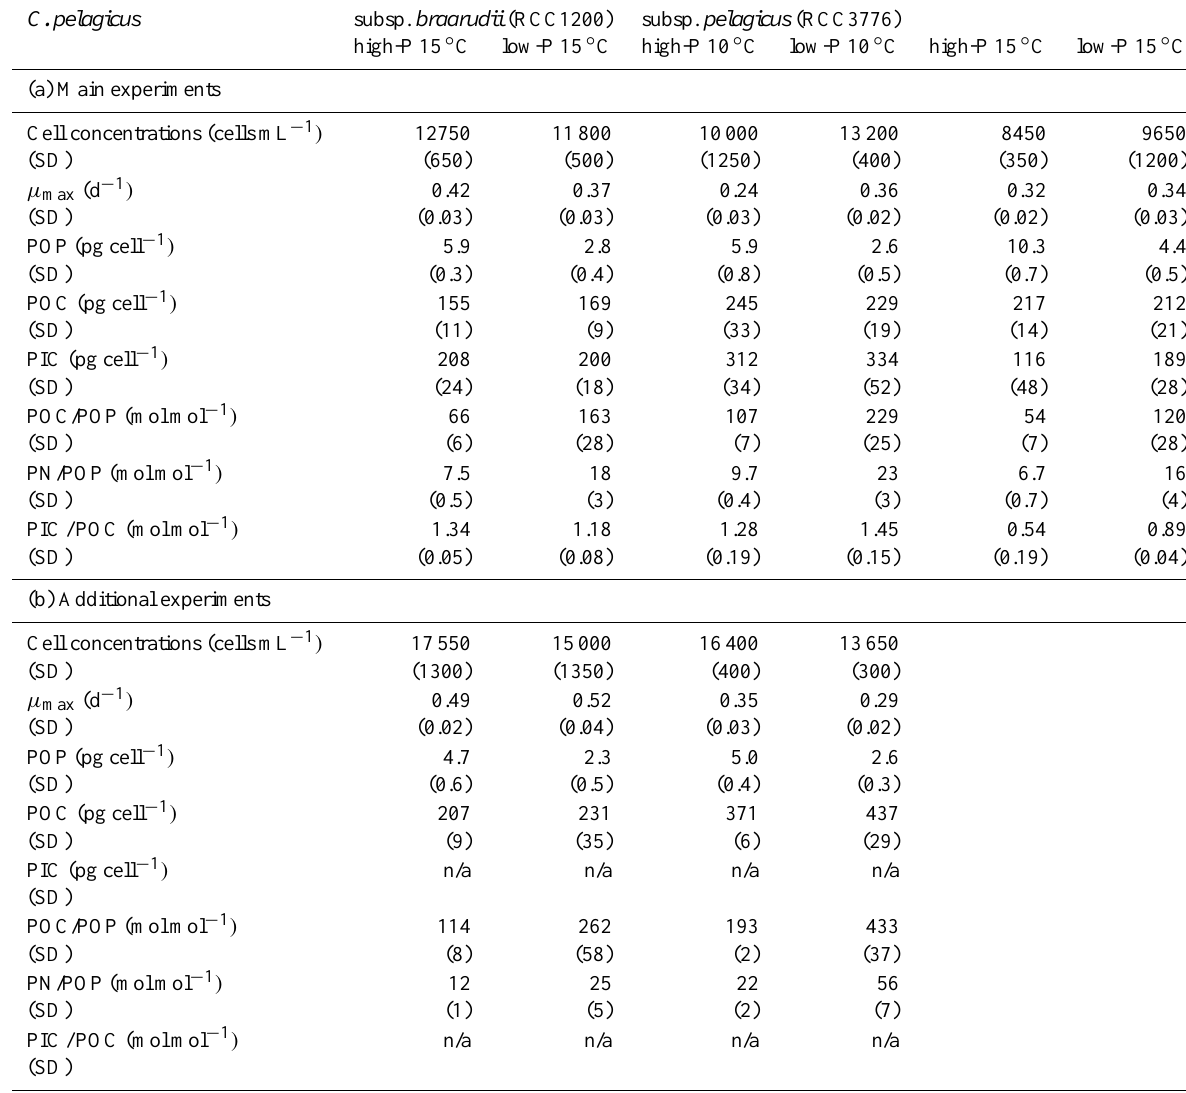
Table 2. Cellular quotas and molar ratios derived from paired high-P and low-P media batch experiments ( n = 3) of Coccolithus pelagicus subsp. braarudii (RCC1200) grown at 15 ◦ C, and subsp. pelagicus (RCC3776) grown at 10 and 15 ◦ C. Note that cell concentrations reflect those at time of sampling, and that maximum growth rate ( µ max ) was calculated during exponential growth phase. Low-P cultures were in stationary phase at time of harvest. Reported are the averages of triplicate batch cultures with standard deviation (SD) in